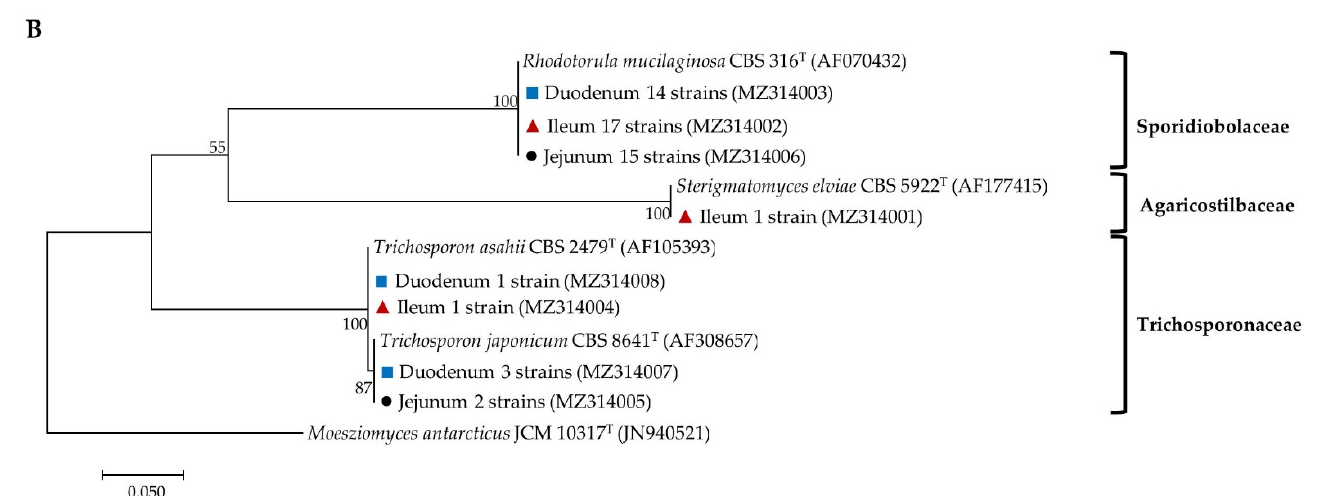
Figure 4. Phylogenetic placement based on the sequence analysis of the D1/D2 domain of the LSU rRNA gene using the Figure 4 . Phylogenetic placement based on the sequence analysis of the D1/D2 domain of the LSU rRNA gene using the Figure 4 . Phylogenetic placement based on the sequence analysis of the D1/D2 domain of the LSU rRNA gene using the Figure 4 . Phylogenetic placement based on the sequence analysis of the D1/D2 domain of the LSU rRNA gene using the maximum-likelihood method (GTR model) of representative yeast species isolated from the small-intestinal epithelium of maximum-likelihood method (GTR model) of representative yeast species isolated from the small-intestinal epithelium of maximum-likelihood method (GTR model) of representative yeast species isolated from the small-intestinal epithelium of maximum-likelihood method (GTR model) of representative yeast species isolated from the small-intestinal epithelium of duodena ( ■ ), jejuna ( ● ) and ilea ( ▲ ) and their closely related type strain sequences received from the GenBank database. duodena ( ■ ), jejuna ( ● ) and ilea ( ▲ ) and their closely related type strain sequences received from the GenBank database. duodena ( ) and their closely related type strain sequences received from the GenBank database. duodena ( ■ ), jejuna ( ● ) and ilea ( ▲ ) and their closely related type strain sequences received from the GenBank database. Numbers on branches demonstrate the bootstrap percentages (>50%), derived from 1000 replications. ( A ) Phylum Asco- Numbers on branches demonstrate the bootstrap percentages (>50%), derived from 1000 replications. ( A ) Phylum Asco- Numbers on branches demonstrate the bootstrap percentages (>50%), derived from 1000 replications. ( A ) Phylum Ascomy- Numbers on branches demonstrate the bootstrap percentages (>50%), derived from 1000 replications. ( A ) Phylum Asco- mycota; scale bar, 0.1 substitutions per nucleotide position; Schizosaccharomyces pombe NRRL Y-12796 T (JQ689077) was used mycota; scale bar, 0.1 substitutions per nucleotide position; Schizosaccharomyces pombe NRRL Y-12796 T (JQ689077) was used mycota; scale bar, 0.1 substitutions per nucleotide position; Schizosaccharomyces pombe NRRL Y-12796 T (JQ689077) was used cota; scale bar, 0.1 substitutions per nucleotide position; Schizosaccharomyces pombe NRRL Y-12796 T (JQ689077) was used as as the outgroup; ( B ) phylum basidiomycota; scale bar, 0.05 substitutions per nucleotide position; Moesziomyces antarcticus as the outgroup; ( B ) phylum basidiomycota; scale bar, 0.05 substitutions per nucleotide position; Moesziomyces antarcticus as the outgroup; ( B ) phylum basidiomycota; scale bar, 0.05 substitutions per nucleotide position; Moesziomyces antarcticus the outgroup; ( B ) phylum basidiomycota; scale bar, 0.05 substitutions per nucleotide position; Moesziomyces antarcticus JCM JCM 10317 T (JN940521) was used as the outgroup. JCM 10317 T (JN940521) was used as the outgroup. JCM 10317 T (JN940521) was used as the outgroup. 10317 T (JN940521) was used as the